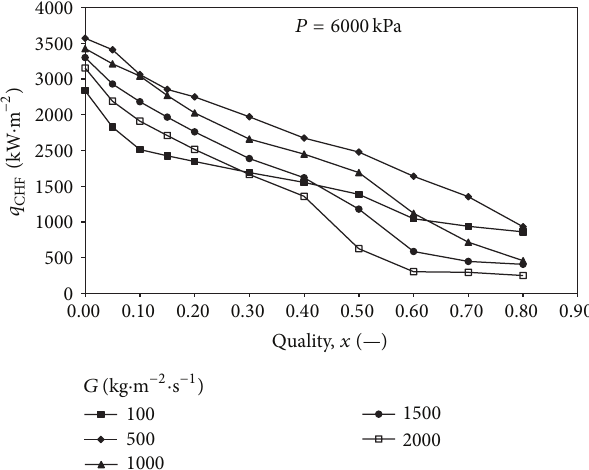
Figure 2: Effect of mass flux on CHF for vertical up-flow of water in 67mm diameter tube as predicted by CHF-LUT.